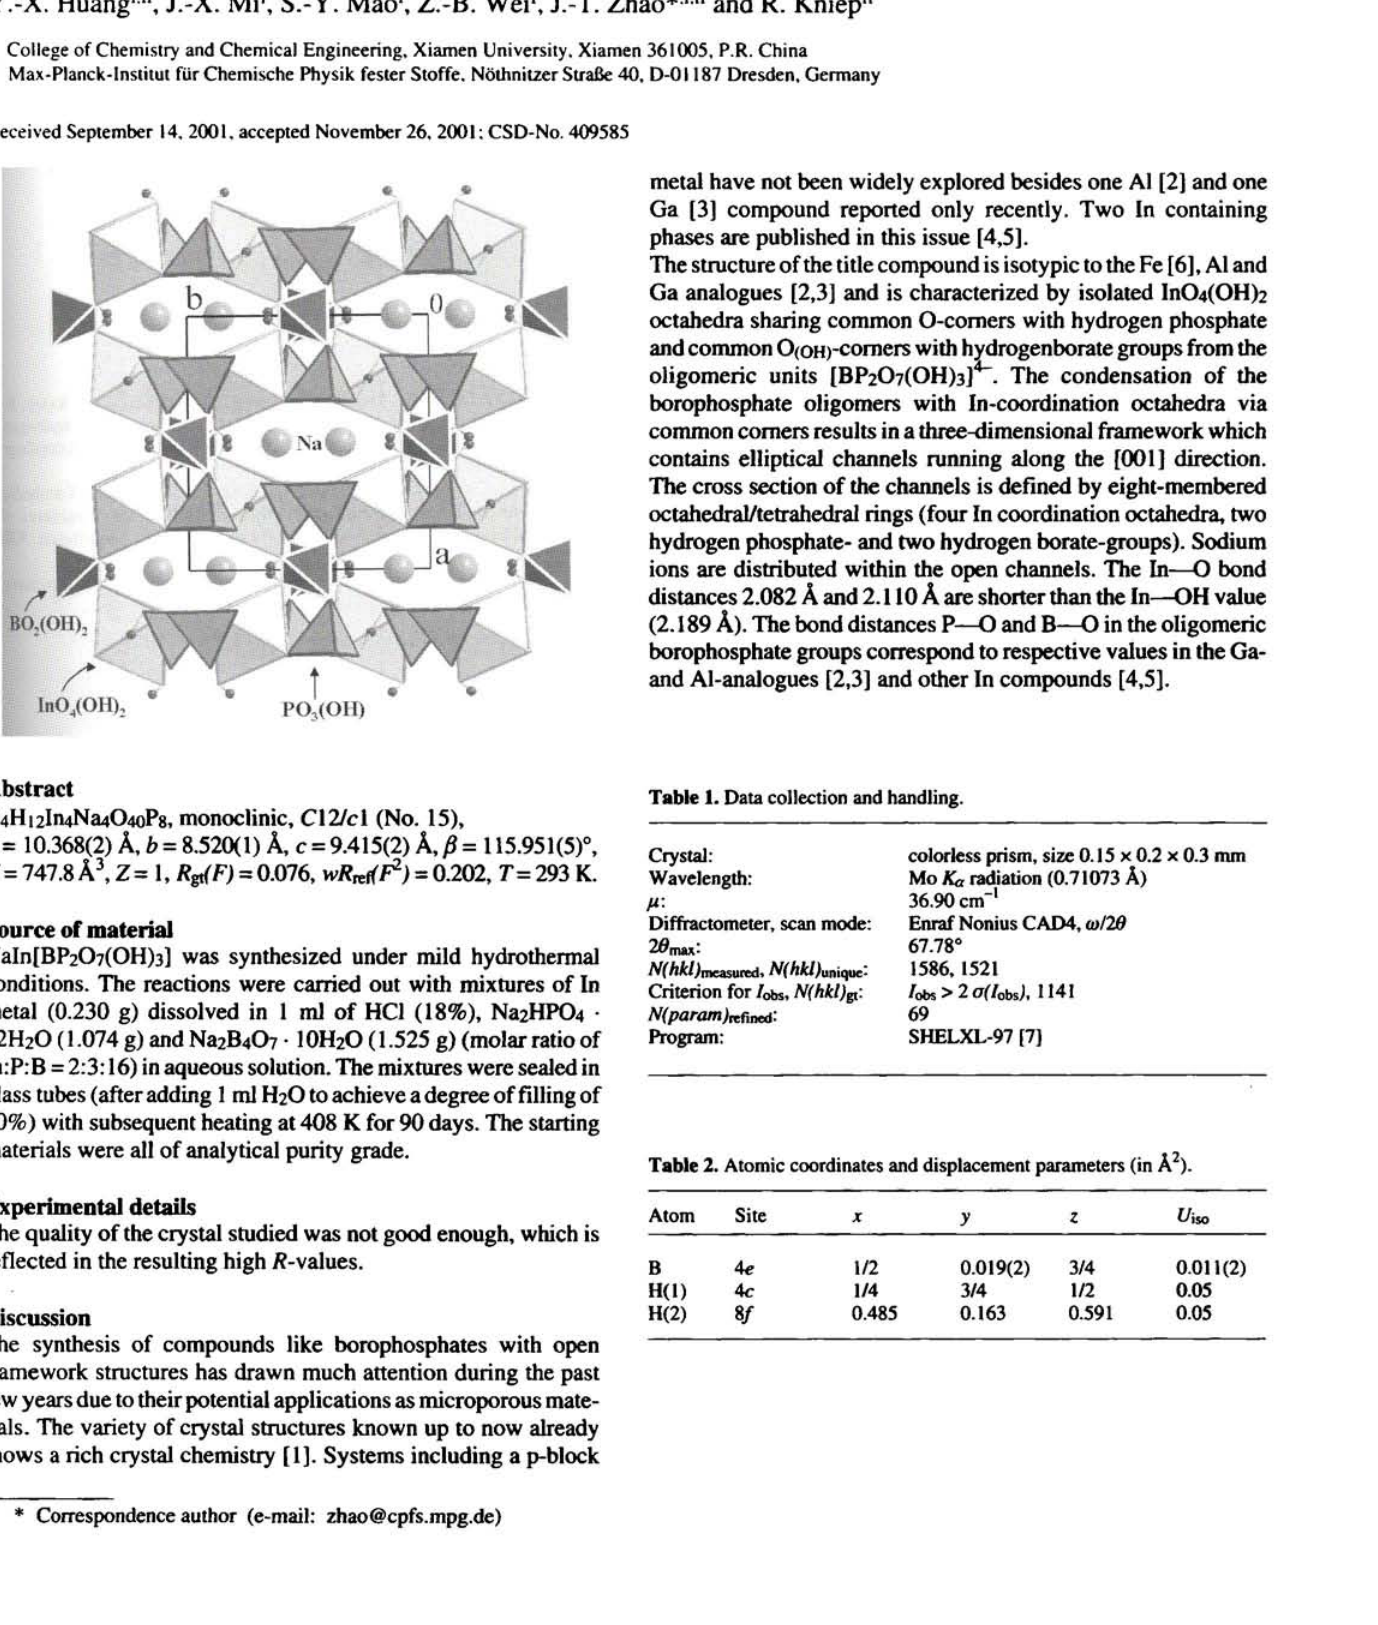
Table 2. Atomic coordinates and displacement parameters (in Â 2